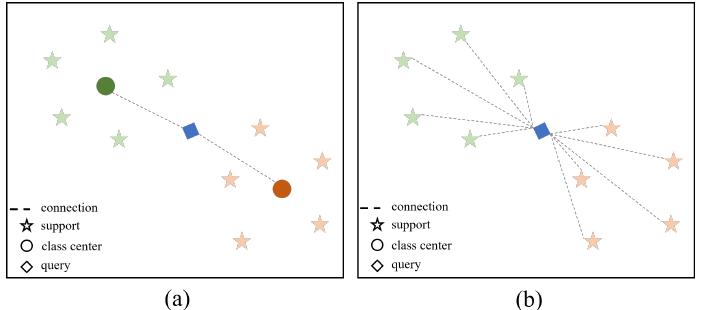
Figure 1. Illustration of different relation-modeling heads in few-shot field. ( a ) The support images of the same class are averaged to form the support center and subsequent modules are used to model the relationship between support centers and the query image. ( b ) Relationships are directly modeled based on all the support images and the query images. To be noted, different colors in the figure indicate different